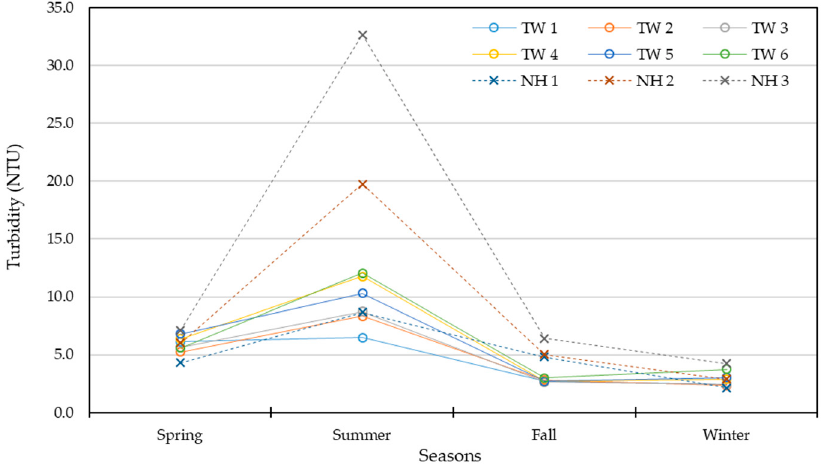
Figure 2. Seasonal turbidity variation of Tseng-Wen reservoir and Nan-Hwa reservoir.